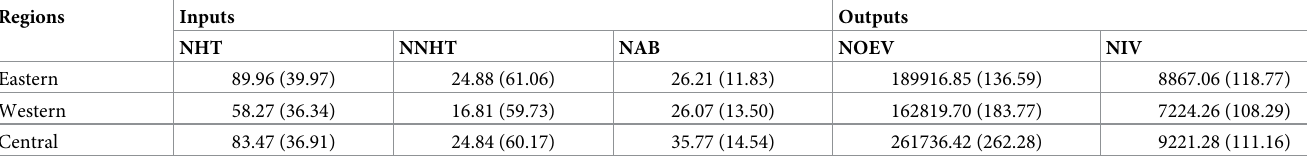
Table 5. Achievable reductions for inputs and improvement for outputs by regions.